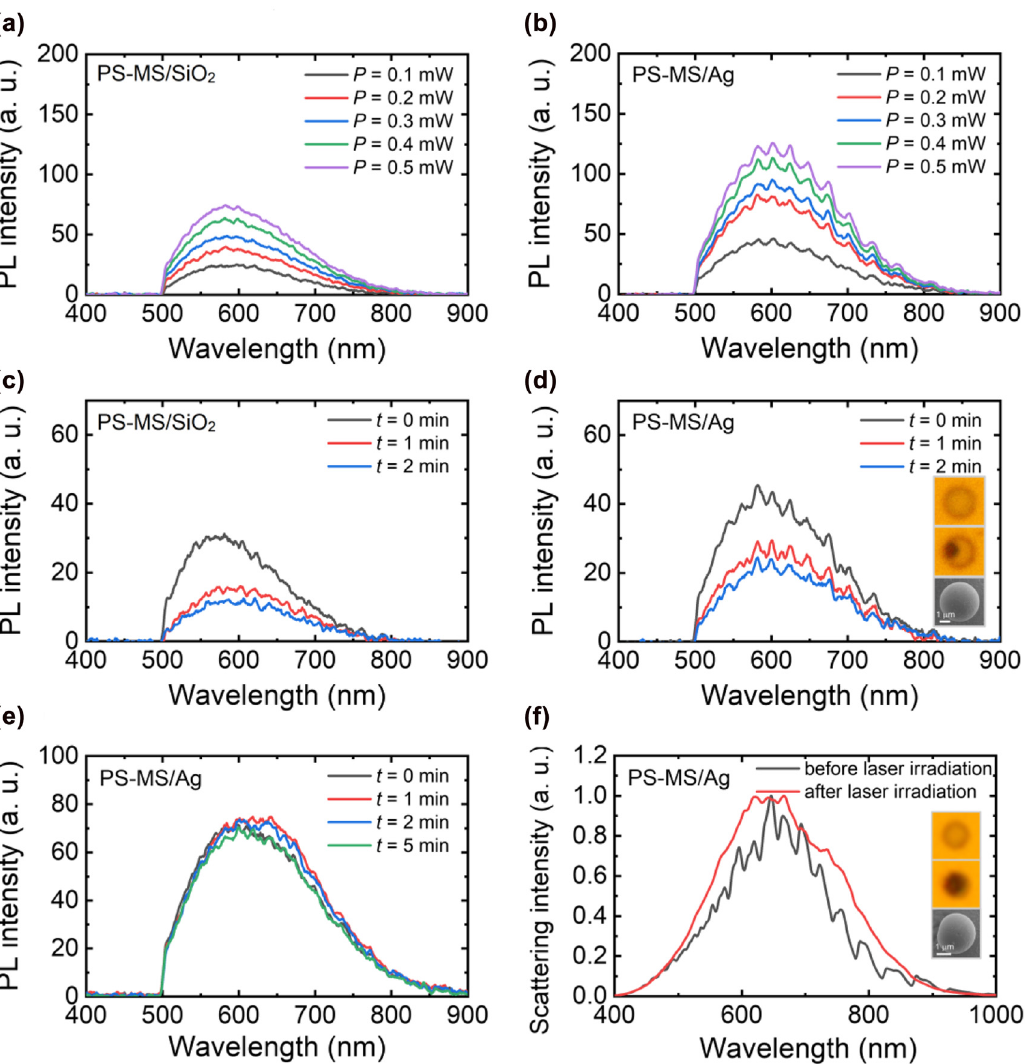
microcavity (a) and the PS-MS/Ag microcavity (b) shown in Figure 2a Figure 4: PL spectra measured at low laser powers for the PS-MS/SiO 2 microcavity and the PS-MS/Ag and e. The evolution of the PL spectrum with increasing irradiation time measured for the PS-MS/SiO 2 microcavity at a laser power of P = 0.05 mW are shown in (c) and (d). (e) Evolution of the PL spectrum with increasing irradiation time measured for another PS-MS/Ag microcavity at a laser power of P = 0.05 mW. (f) Scattering spectra measured for the PS-MS/Ag microcavity shown in (e) before (black curve) and after (red curve) laser irradiation. The bright-field images of the PS-MS/Ag microcavity before and after laser irradiation and the SEM image of the PS-MS/Ag microcavity after laser irradiation are shown in the